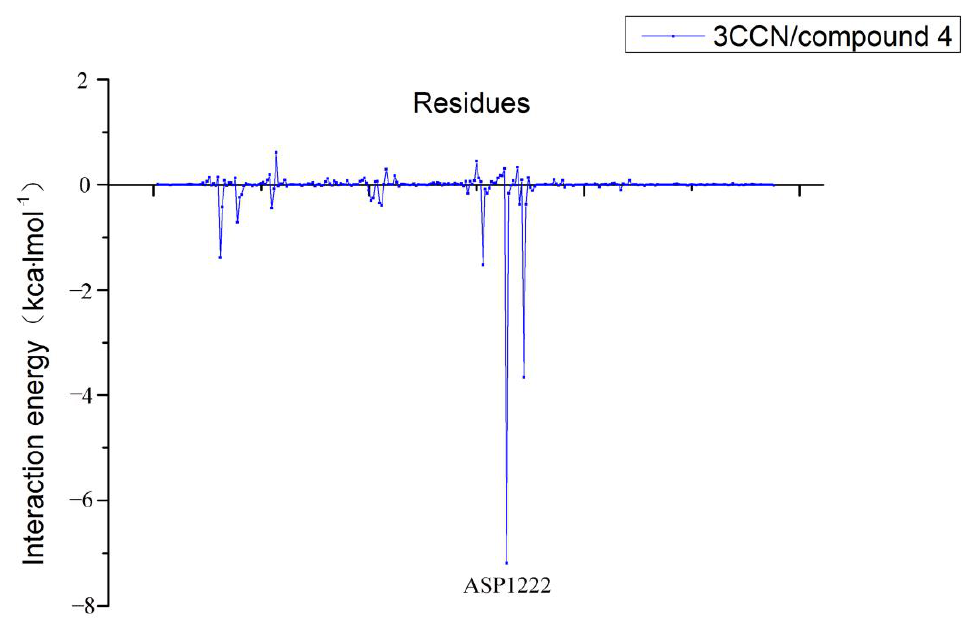
Figure 12. Contribution of partial residues calculated by decomposing the binding energy.